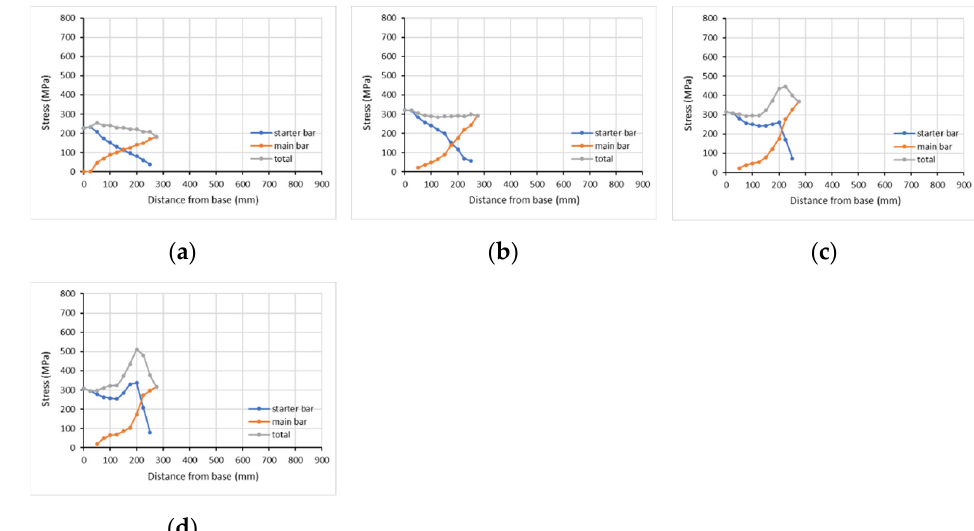
Figure 16. Developed stress along lap splice length at a displacement of ( a ) 3.44 mm, ( b ) 7.23 mm,